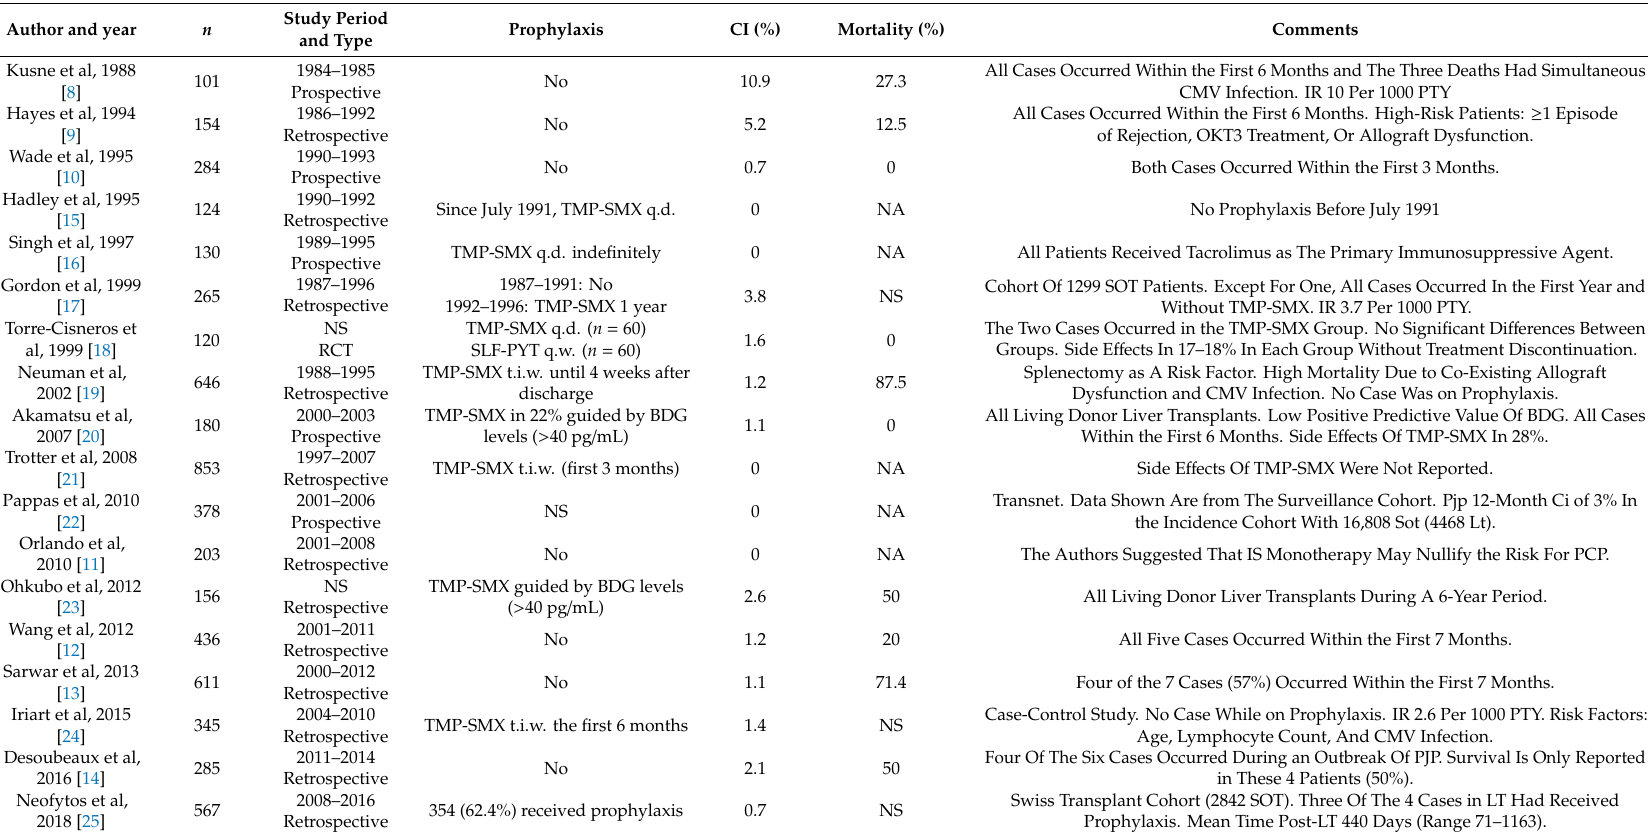
Table 1. Large studies evaluating the incidence of Pneumocystis jirovecii pneumonia in liver transplant recipients in the presence or absence of prophylaxis